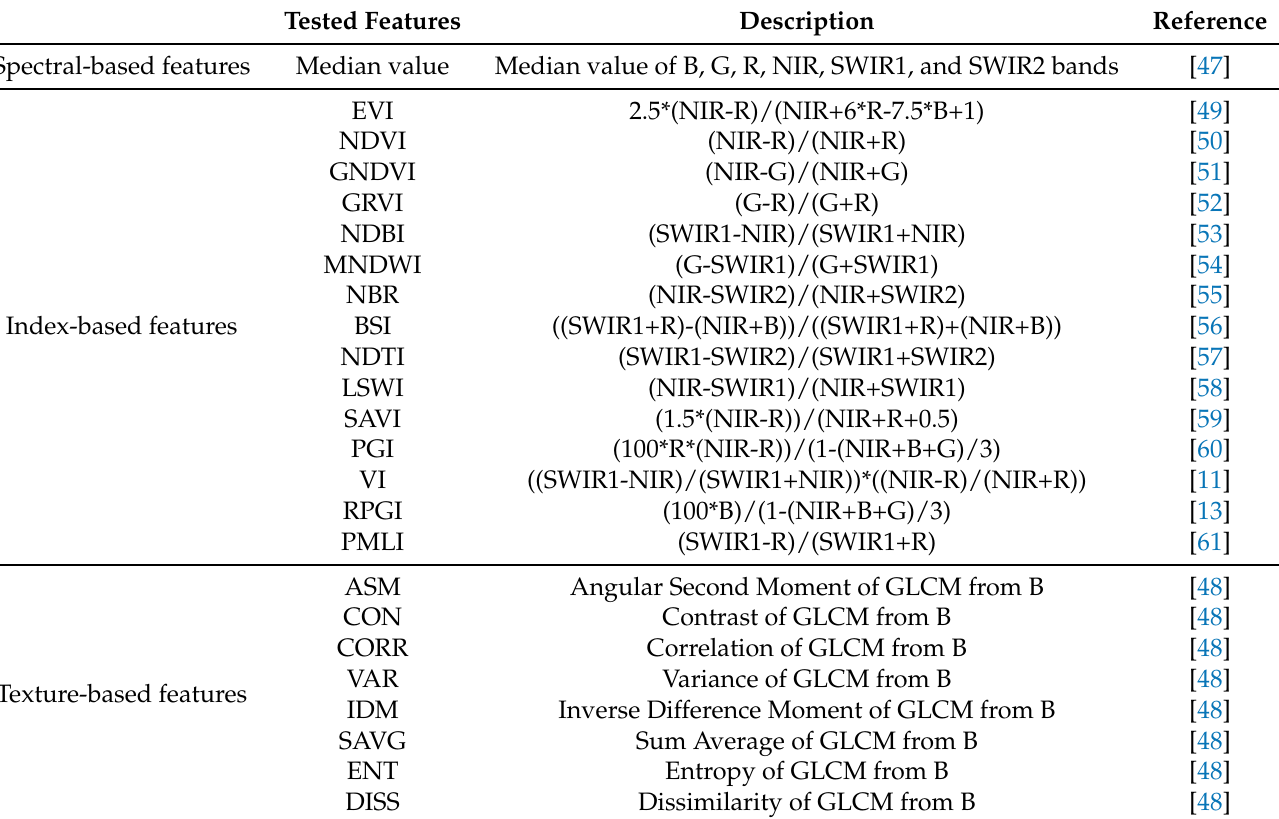
Table 2. Landsat time-series features. GLCM, gray-level co-occurrence matrix; NIR, near-infrared; SWIR1,